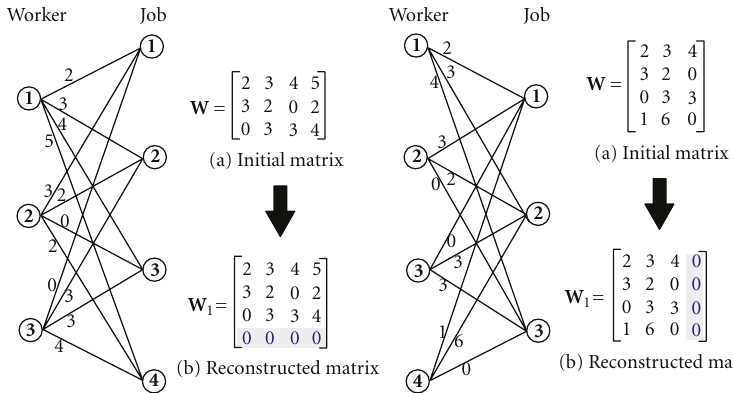
Figure 3: Asymmetric bipartite matching without resource reallocation.